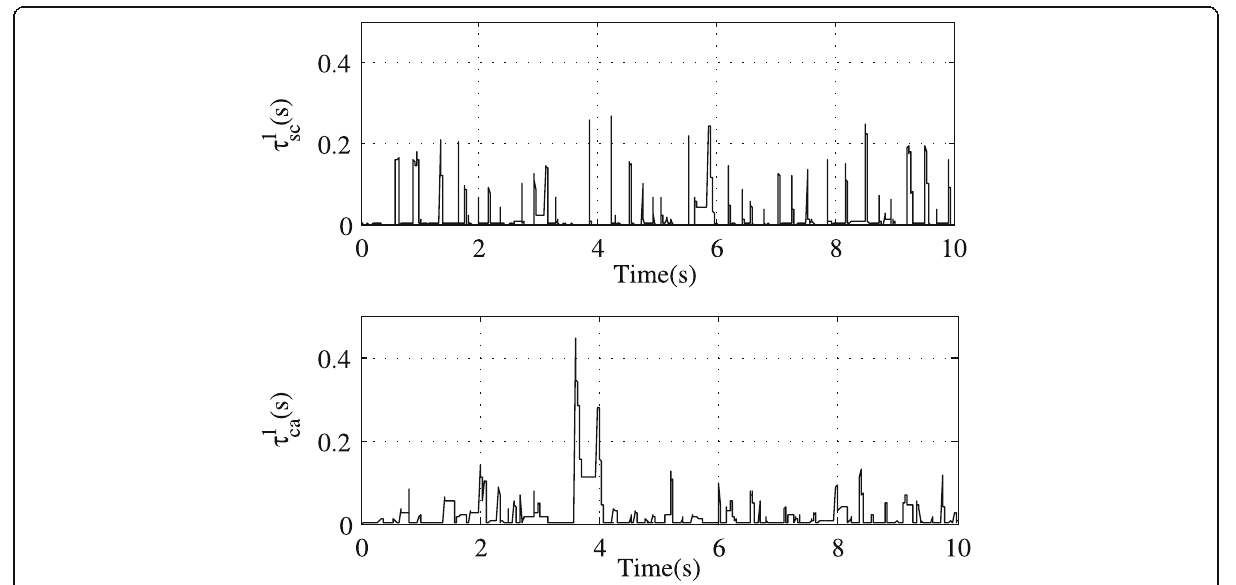
Fig. 11 The SC and CA delay distributions of loop 1 when parameter perturbation and communication network change